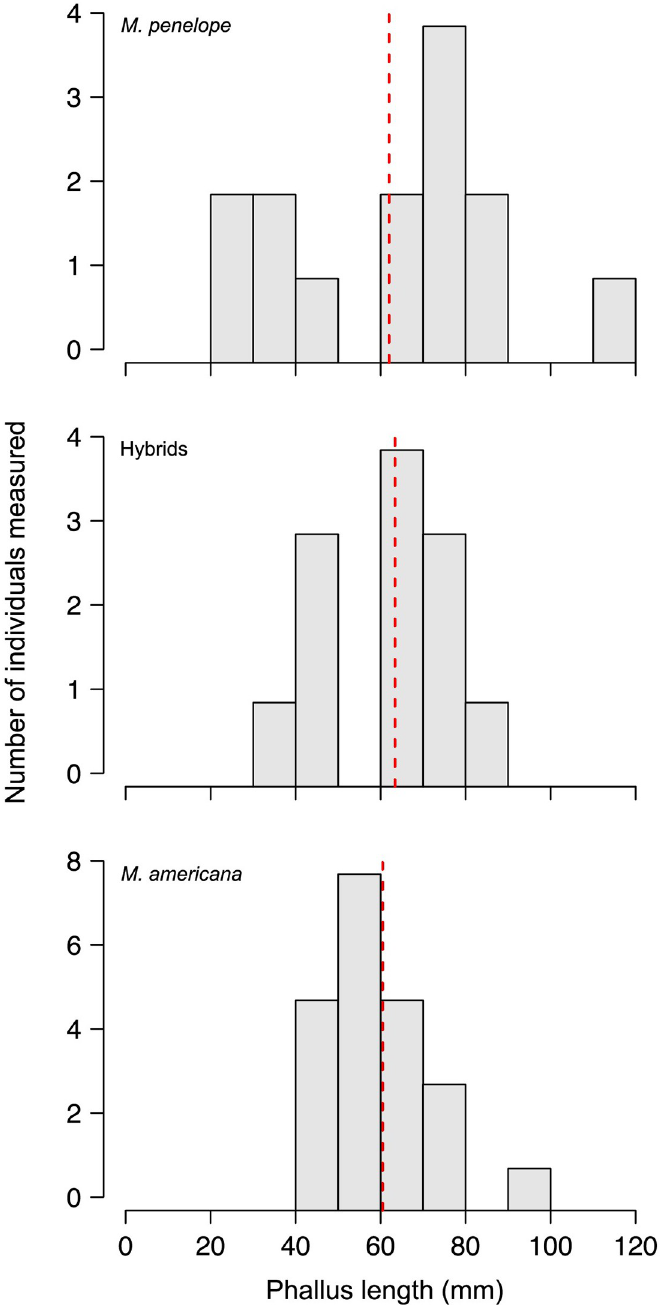
Fig 2. Stacked histograms of phallus lengths for winter taken adult American and Eurasian wigeon and their hybrids. Means are essentially identical.